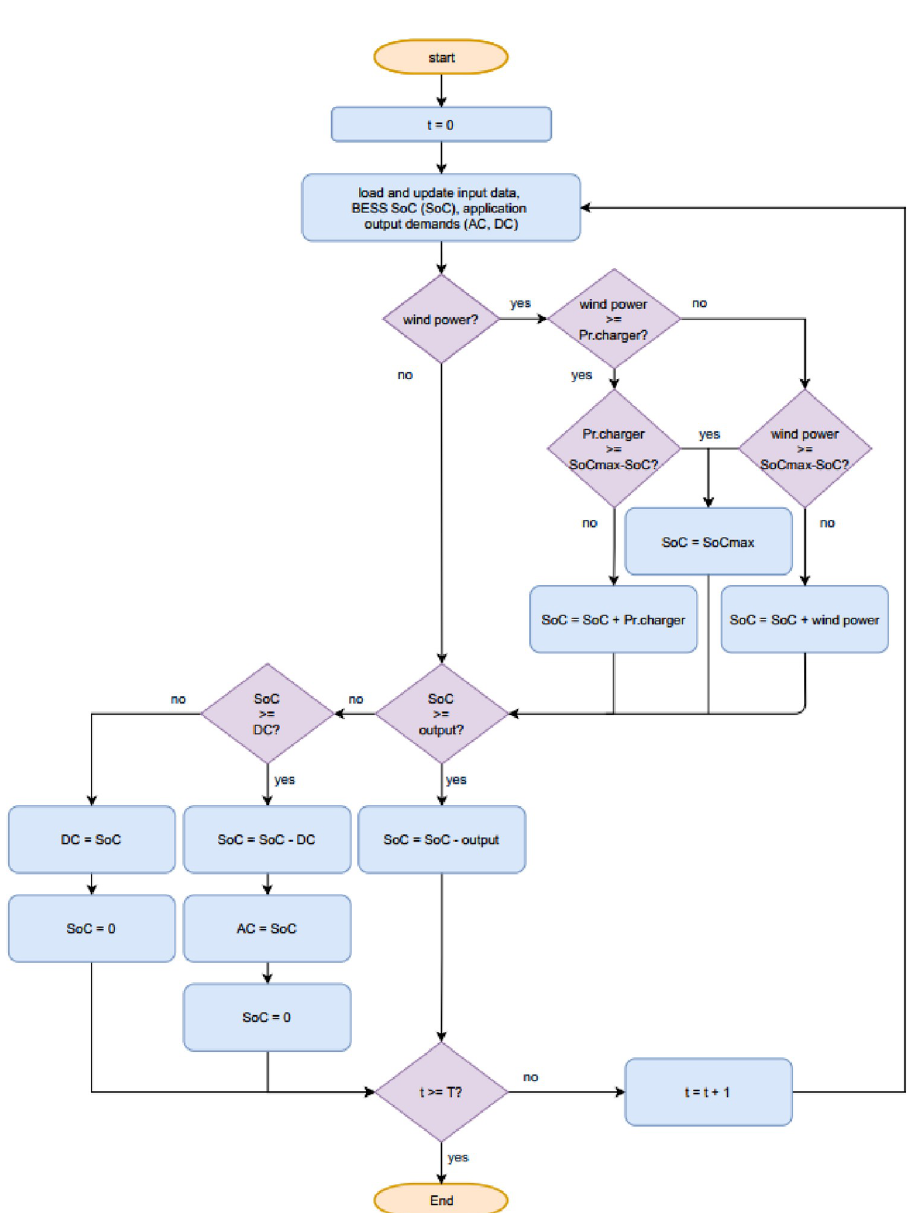
Fig 6. The flowchart of supplying all demands while prioritizing the DC